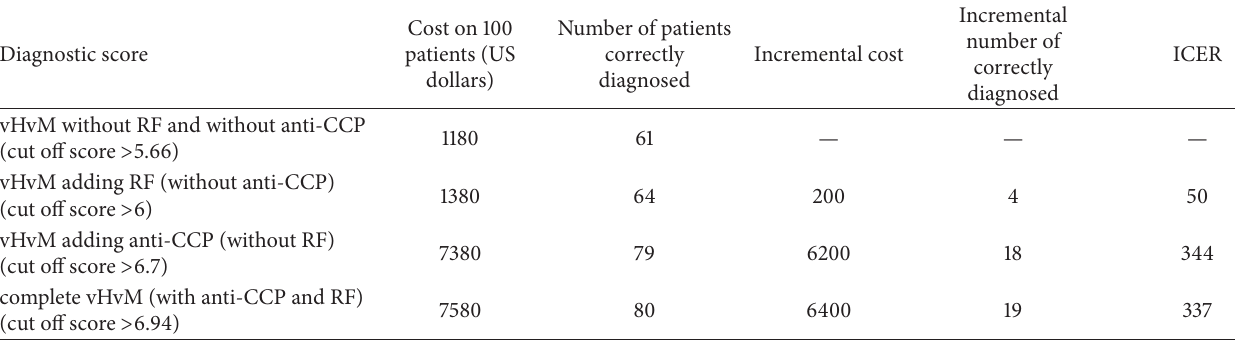
Table 5: Cost effectiveness ratio for complete van der Helm-van Mil prediction score, score without anti-CCP, score without RF, and score without anti-CCP and without RF.